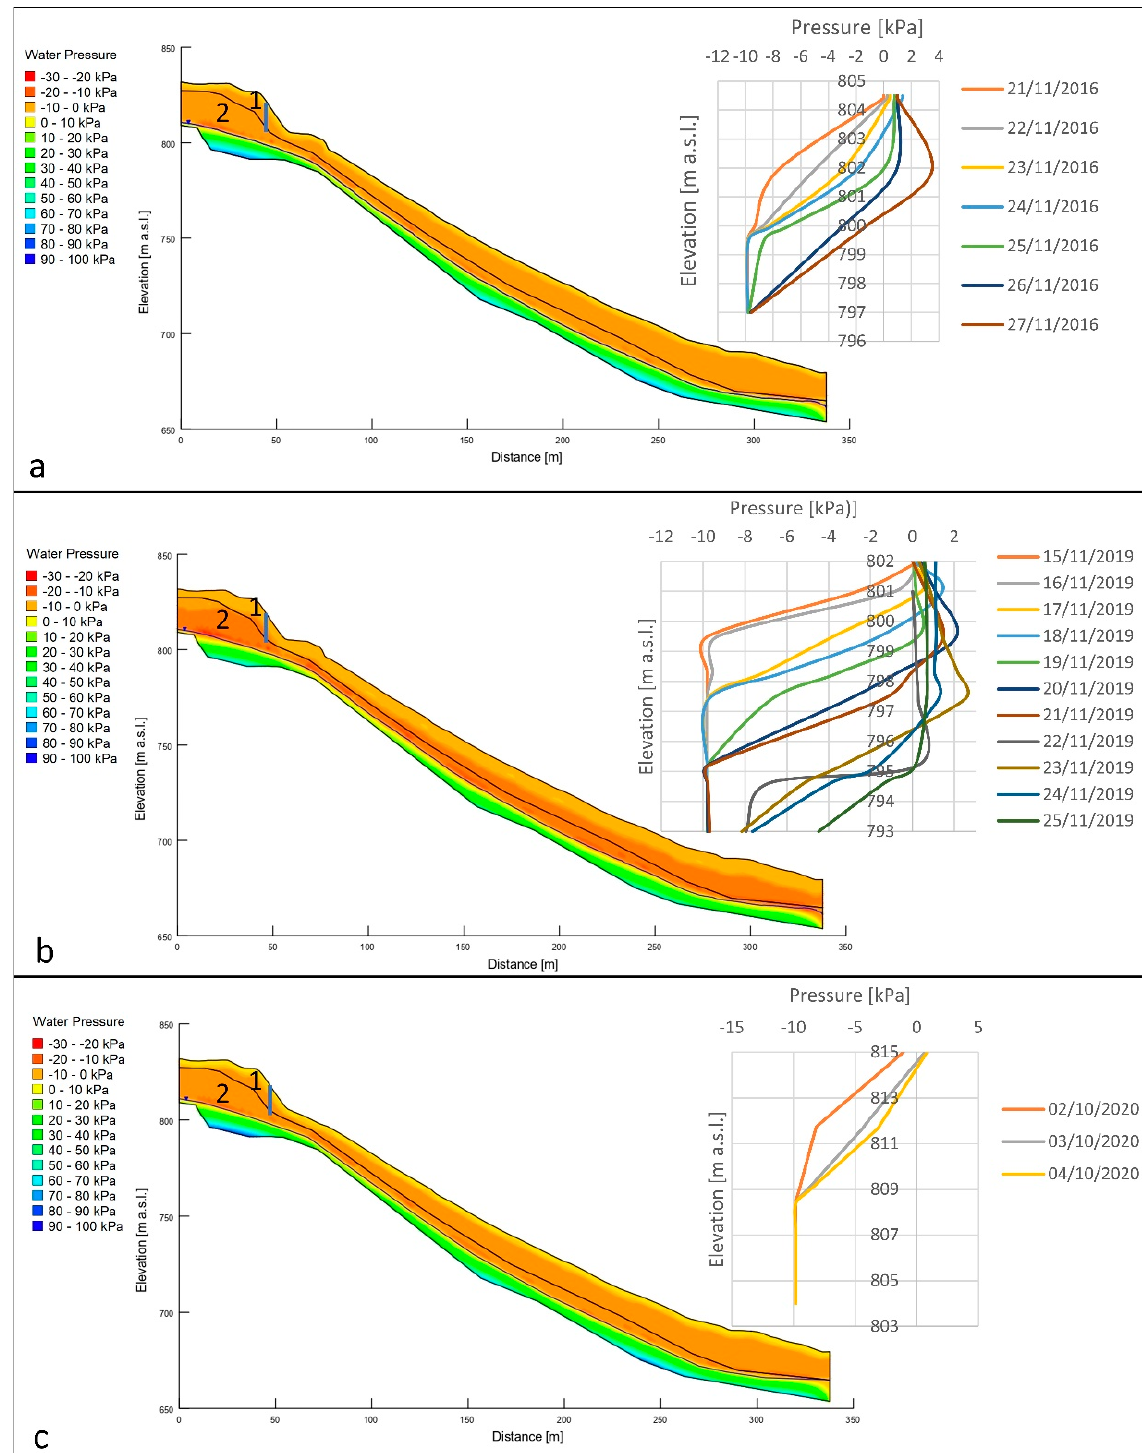
Figure 10. Distribution of interstitial pressures in the slope (Section A–A’) during selected storm Figure 10. ( a ) Geotechnical slope model along section A–A’ reconstructed along the line of maximum phases: ( a ) November 2016 event; ( b ) November 2019 event; and ( c ) October 2020 event. The blue slope for the last landslide event. 1: Layer 1, sand with gravel; 2: Layer 2, weakly gravelly sand; and line in each section represents the vertical transect for which interstitial pressure variations were 3: Layer 3, bedrock. ( b ) Zoom of the area with the locations of the gabions. ( c ) The table shows the geotechnical and hydrological parameters of the two modelled analysed and graphed. 1 Layer 1; and 2 Layer 2.